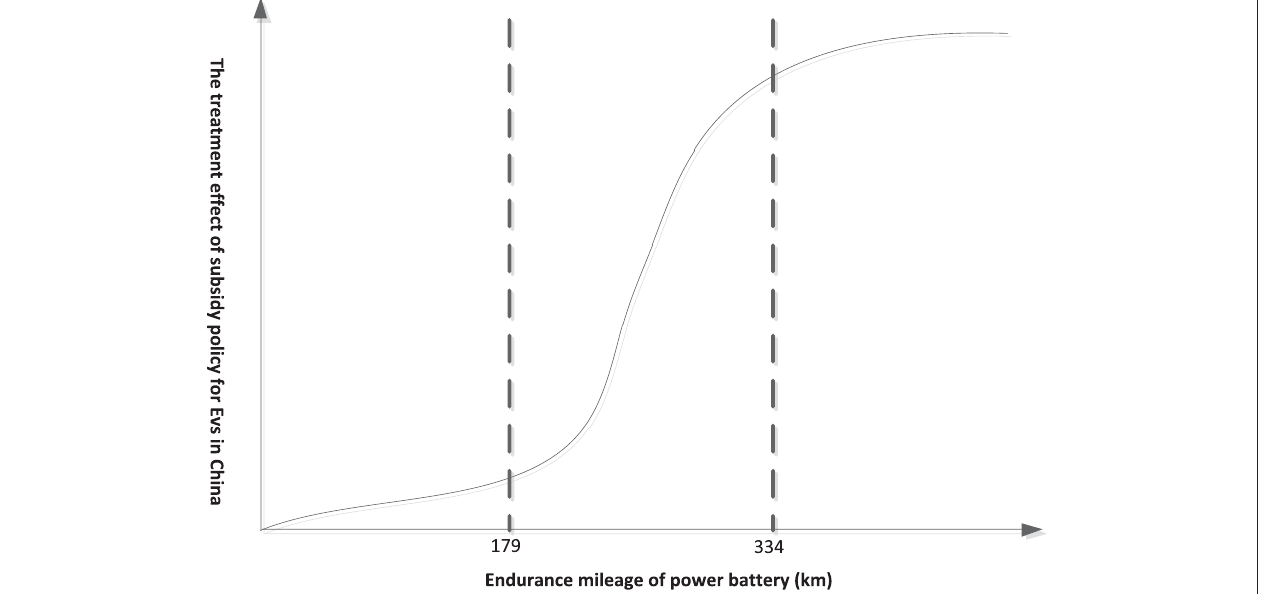
Frontiers in Energy Research |